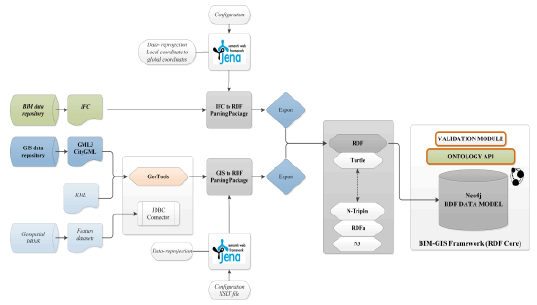
Figure 11: High-level system architecture